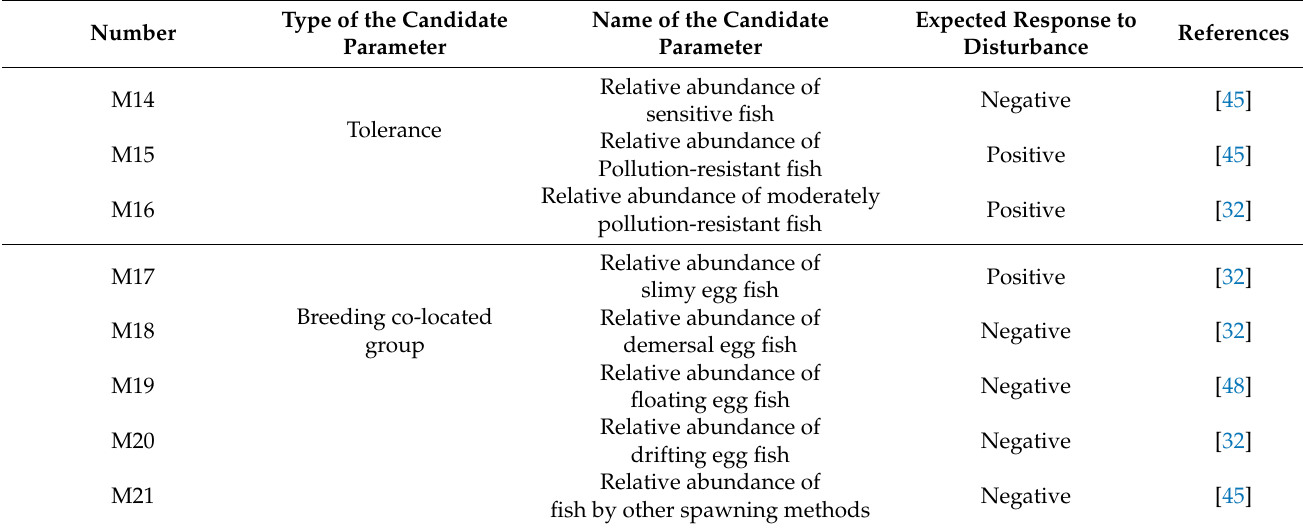
Figure 3. Community composition and relative abundance distribution of fish species (top 22) were revealed by eDNA metabarcoding at each sampling site. ( A ) Top 22 fish species in order of abun- dance. ( B ) Relative abundance distribution of each species at the sampling sites. 3.2. Differences in the Composition of the Fish Community in Dianchi Lake and the Three In- flowing Rivers Distinct differences in the composition of fish communities were observed between Dianchi Lake and the three inflowing rivers. PCo1 and PCo2 explained 45.5% of the dif- ferences, and Dianchi Lake was significantly different from the three inflowing rivers. However, the fish community structures among the three rivers were not significantly separated (Figure 4). There were significant differences in the composition of fish communities among the three inflowing rivers (PERMANOVA test, p < 0.01) (Table 2). The explicable part (R 2 ) of the PCoA diagram that overlapped with more groups was small. Although there were significant differences in the composition of fish communities among the three rivers, R 2 was only 13.42%, indicating that the location of the three rivers contributed significantly but accounted for a small proportion.